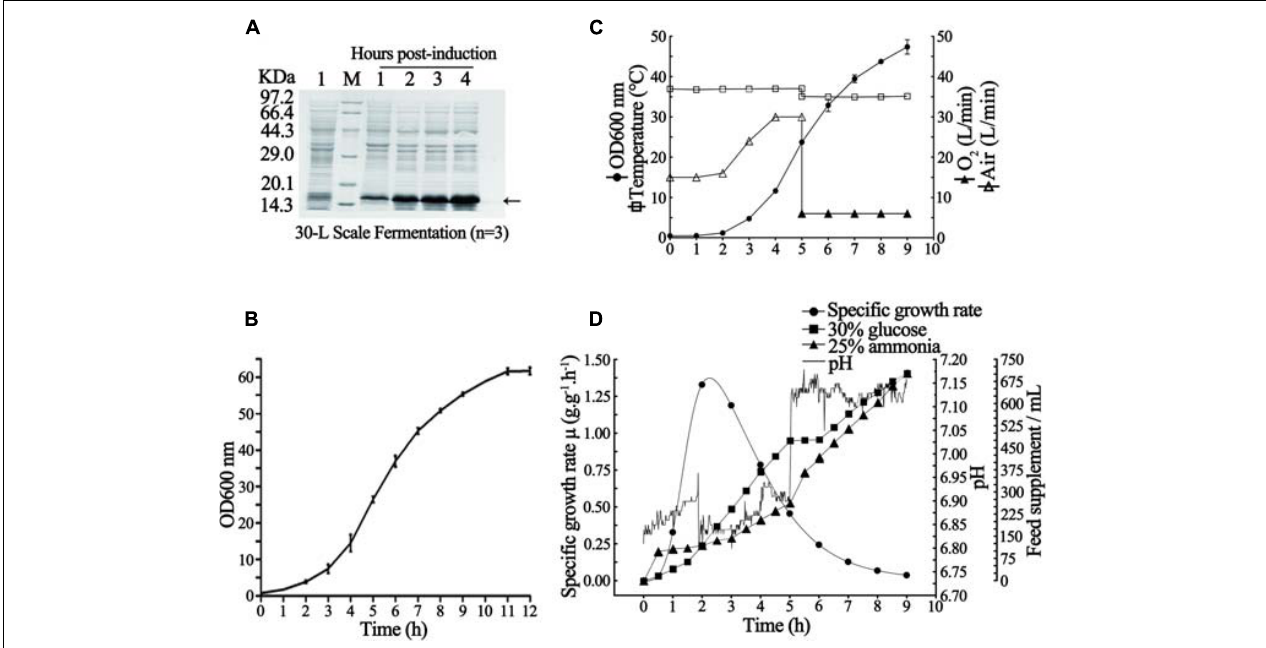
FIGURE 4 | Fermentation process of E. coli BL21(DE3) plysS-pET3c/rhaFGF 135 . (A) rhaFGF 135 expression SDS-PAGE analysis at the 30-L fermentation scale. Lane 1, non-induced. Lane M, molecular weight marker. (B) Growth curve of rhaFGF 135 E. coli strain in a 30-L fermenter. (C) Variations in the parameters in the rhaFGF 135 production at 30-L scale fermentation, including wet cell concentration (OD 600 ), temperature, and ventilation rate of air or pure oxygen. (D) The relation curve of specific growth rate, glucose addition, pH, and ammonia addition with time in 30-L scale fermentation process. The arrow indicates rhaFGF 135 .